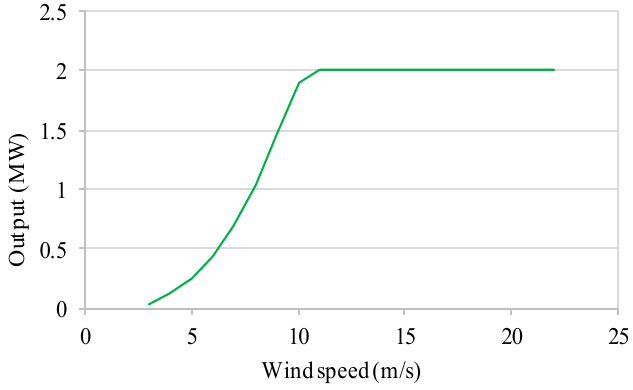
Figure A3. Wind turbine power curve (rated capacity is 2 MW, source: POWERCHINA Kunming Engineering Corporation Ltd.).